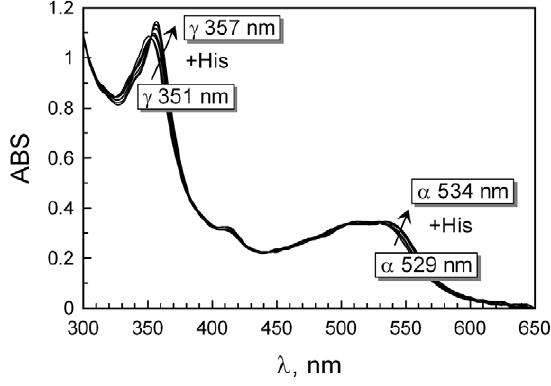
Figure 5. Absorbance Spectra of Cobalamin bound to Purified Zebrafish Cobalamin Binder. Spectral characteristics of the zebra- fish cobalamin binder in complex with hydroxo-cobalamin are shown. Spectral transition after addition of 15 mM histidine was recorded after 1, 3, 5, 12, 20, and 30 minutes of incubation at room temperature. The arrows indicate the direction of this